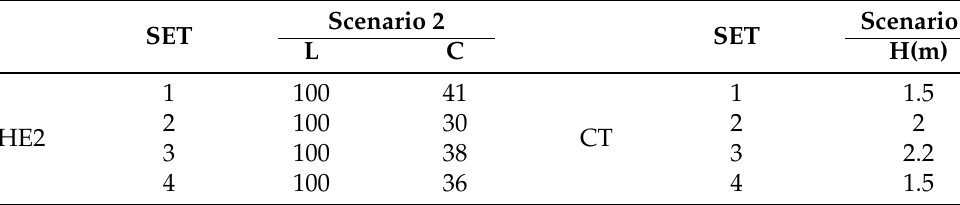
Table A2. The lines (L) and columns (C) of the HE2 units and the heights (H) of the cooling tower.